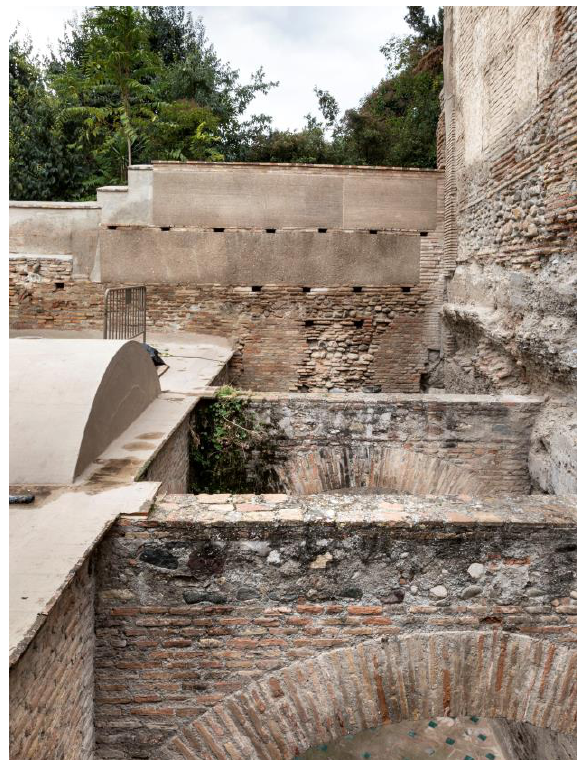
Figure 1. Overview of the service room of the Bañuelo. At the bottom: west dividing wall. Photograph: Cristina